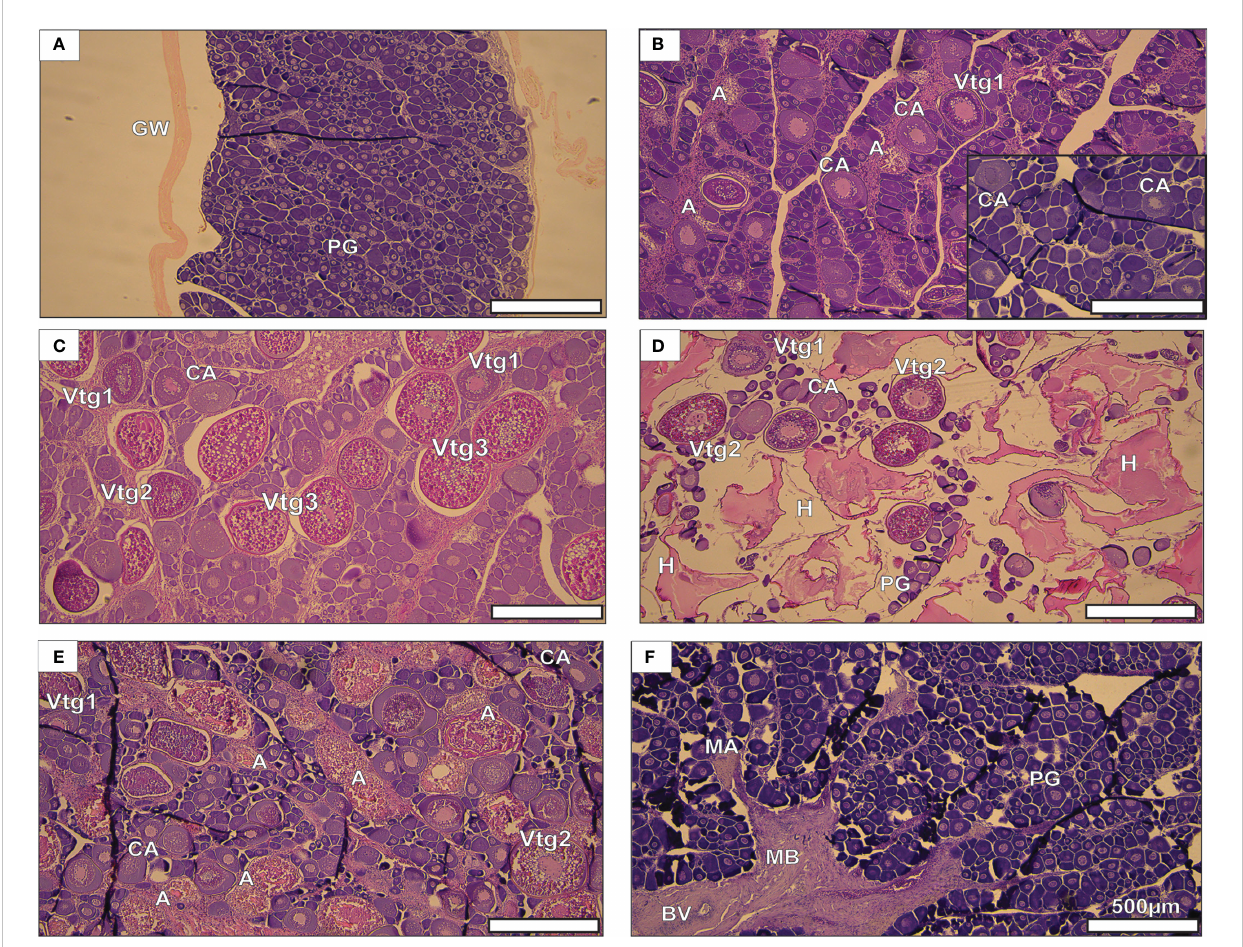
FIGURE 3 Etelis coruscans gonadal histology depicting reproductive phases. (A) immature, (B) developing, (C) spawning capable, (D) actively spawning sub- phase, (E) regressing, and (F) regenerating. The insert in B) is the early developing subphase and it is to scale with the other images. The scale bar of 500 µm applies to all images. Abbreviations for histological characteristics include: A, atresia; MA, macrophage aggregate; BV, blood vessel; CA, cortical aveoloar; GW, gonad wall; MB, muscle bundle; PG, primary growth; Vtg 1, primary vitellogenic; Vtg2, secondary vitellogenic; Vtg3, tertiary vitellogenic; H, hydrated